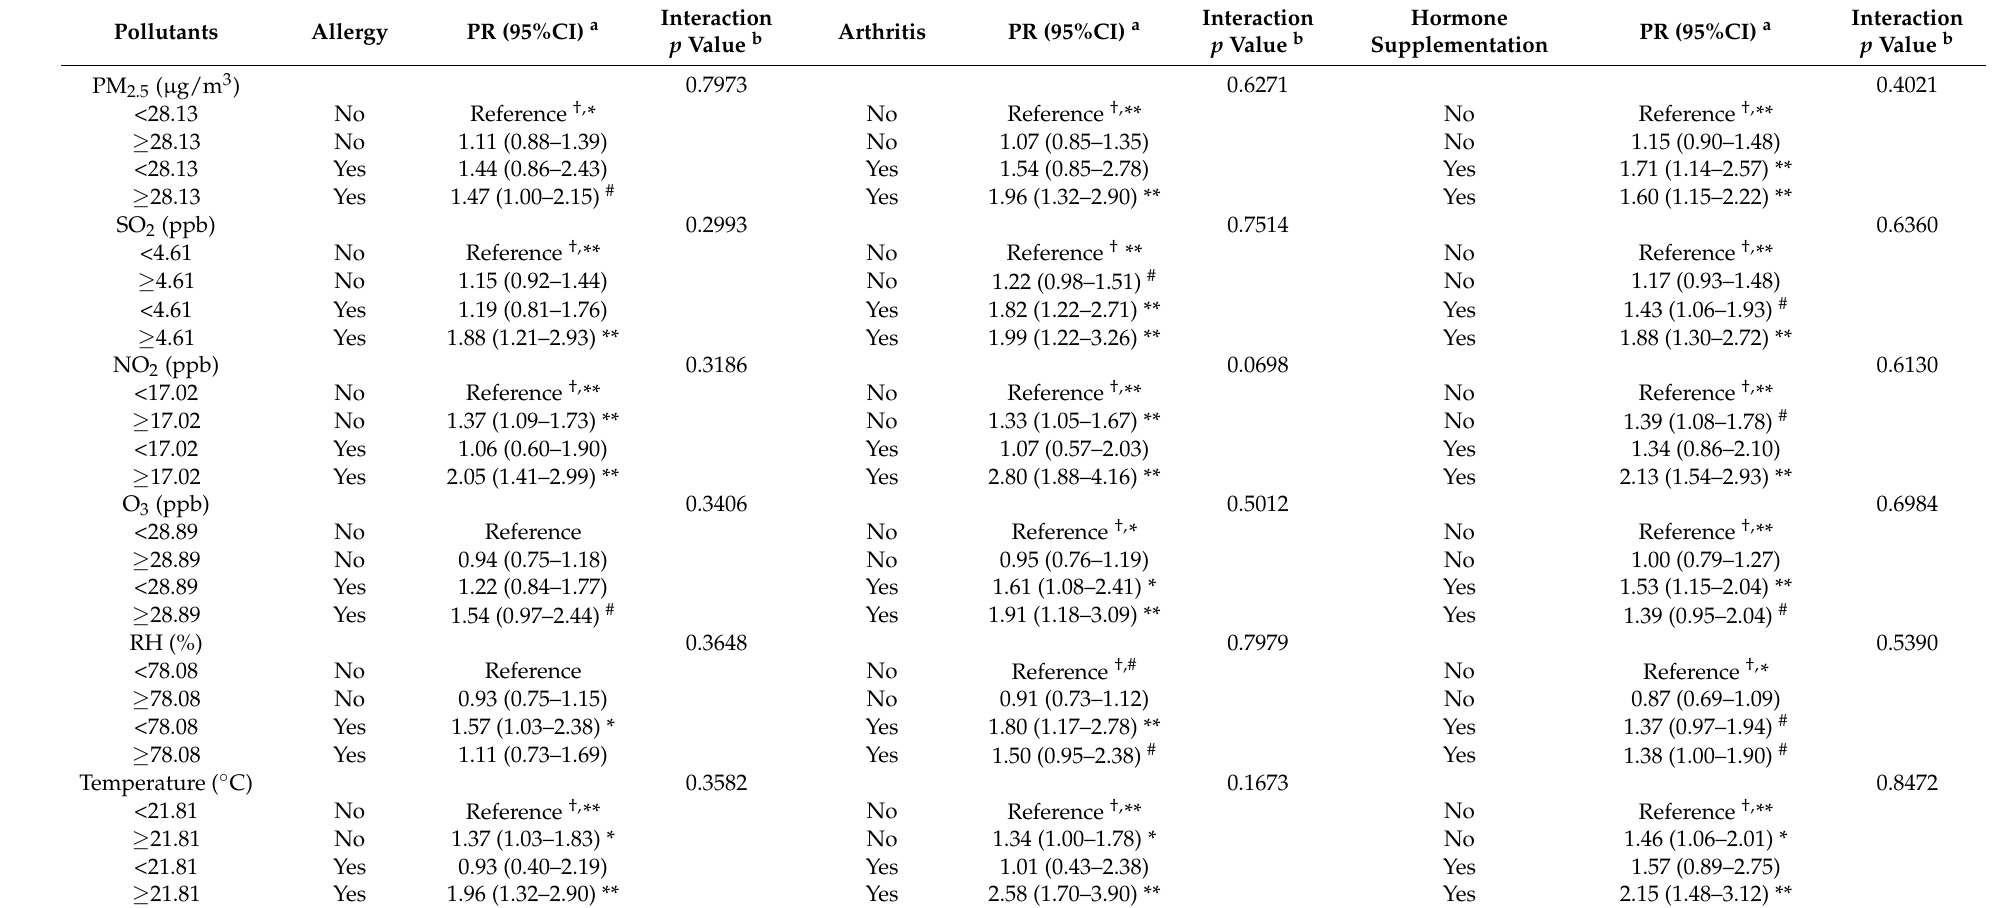
Table 4. Interactions of various air pollutants and clinical diseases on risk of dry eye syndrome using multiple logistic